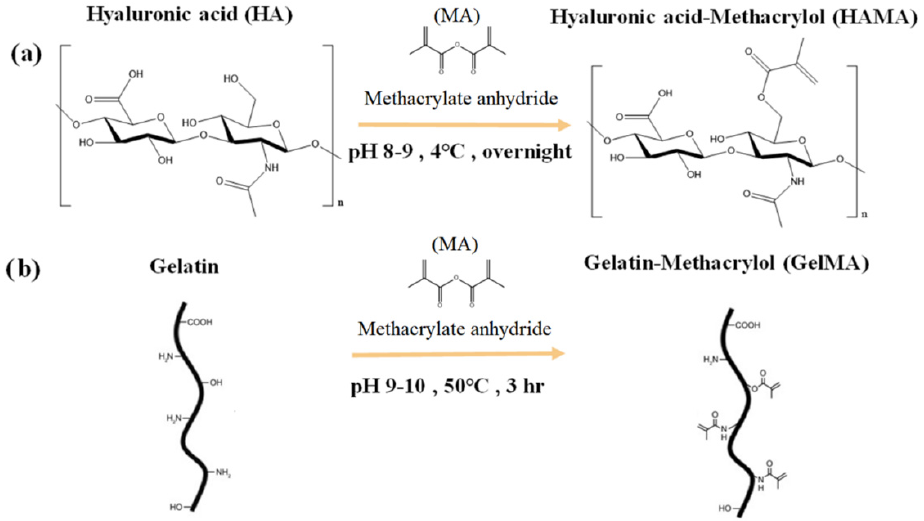
Figure 2. Schematic synthesis of the photo cross–linkable HAMA and GelMA hydrogels. The synthesis of hyaluronic acid methacrylol (HAMA) hydrogel ( a ); The synthesis step of gelatin methacrylol (GelMA) hydrogel ( b ).